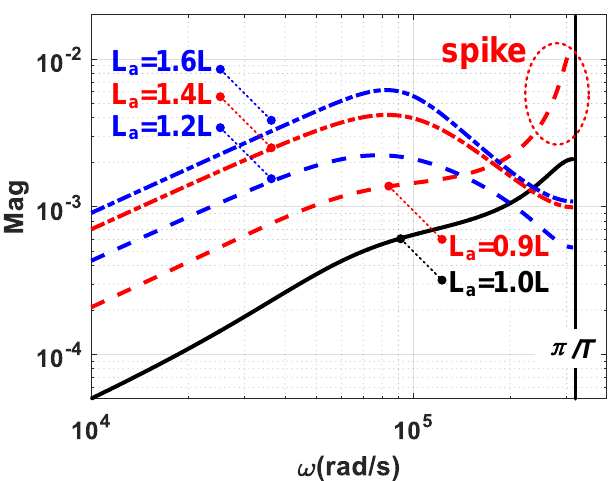
Figure 16. Closed-loop frequency analyses under DPVP control for the v in - > v out, s transient under deviated inductance.